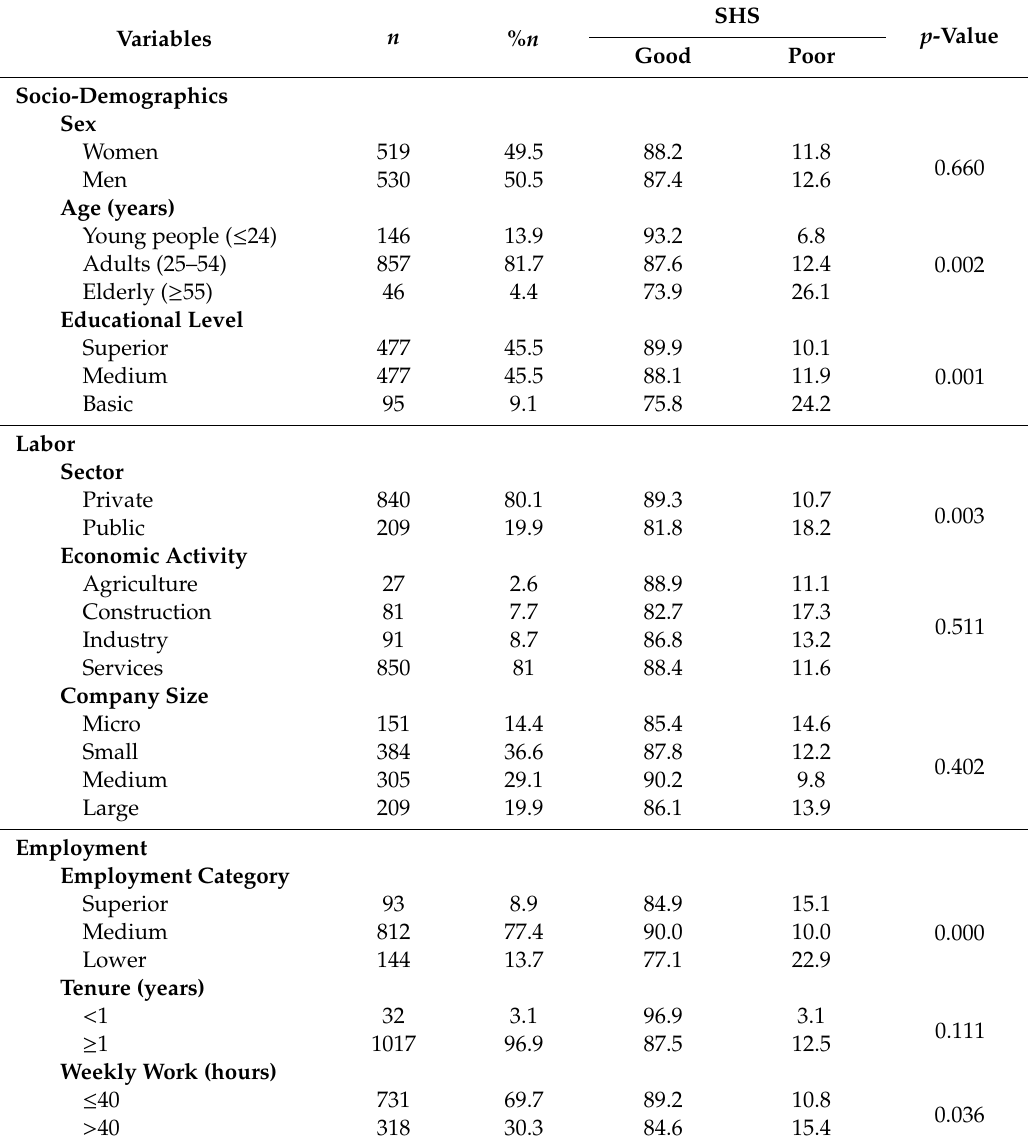
Table 1. General characteristics and self-perceived health (SHS) of the sample ( n = 1049).